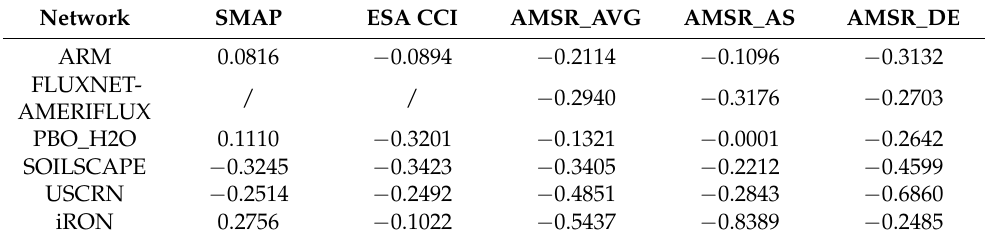
Table 3. PBIAS of five products over different observation networks.